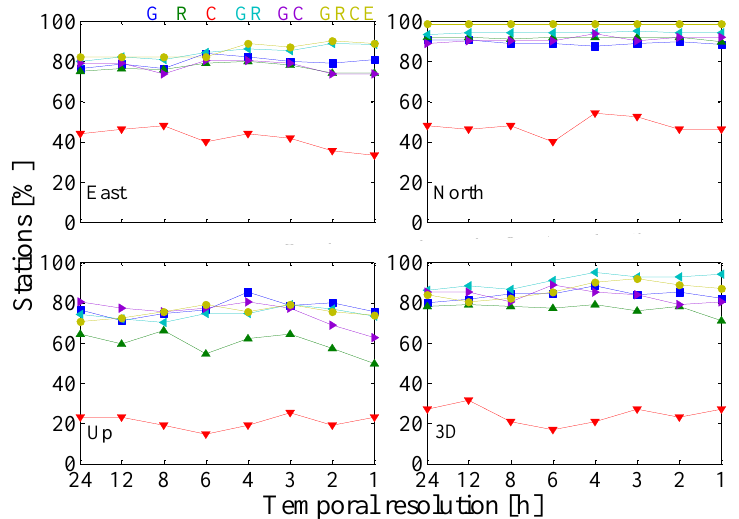
Figure 3. Station percentage with improved position repeatability (east, north, up and 3D components) derived from GPS-, GLONASS-, BDS-only, GPS + GLONASS, GPS + BDS and GPS + GLONASS + BDS + Galileo PPP solutions as a function of temporal resolutions with respect to “No_SYS” solutions. Different constellation combinations of G, R, C, GR, GC and GRCE are depicted in different colors.